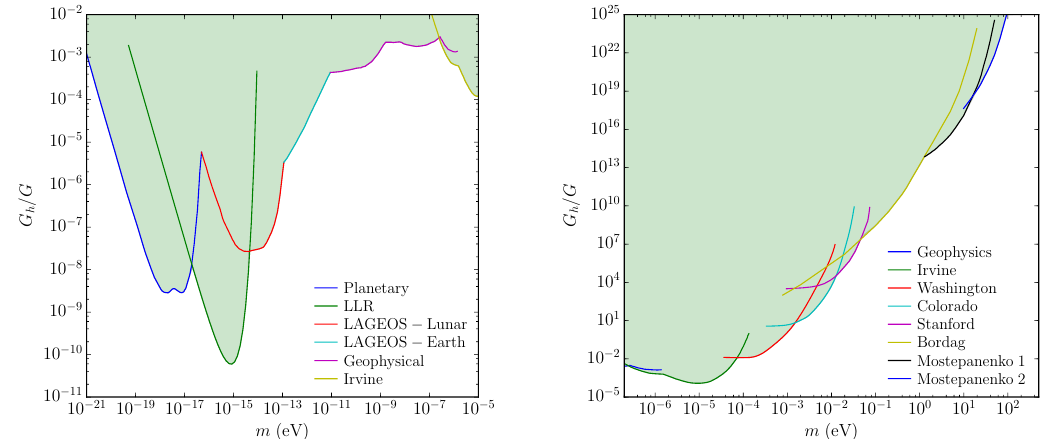
Figure 1 . Constraints on the hidden-graviton mass and coupling G h , relative to the standard- graviton coupling. The shadowed region is excluded by (cid:12)fth-force tests. The curves have been adapted from the following references: planetary, LLR, LAGEOS-Lunar, LAGEOS-Earth,